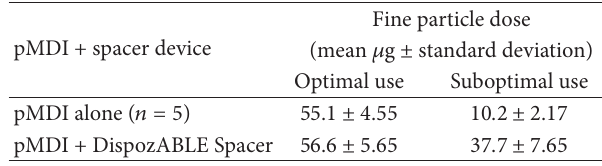
Table 1: Fine particle dose data (particle size < 5 𝜇 m, mean 𝜇 g ± standard